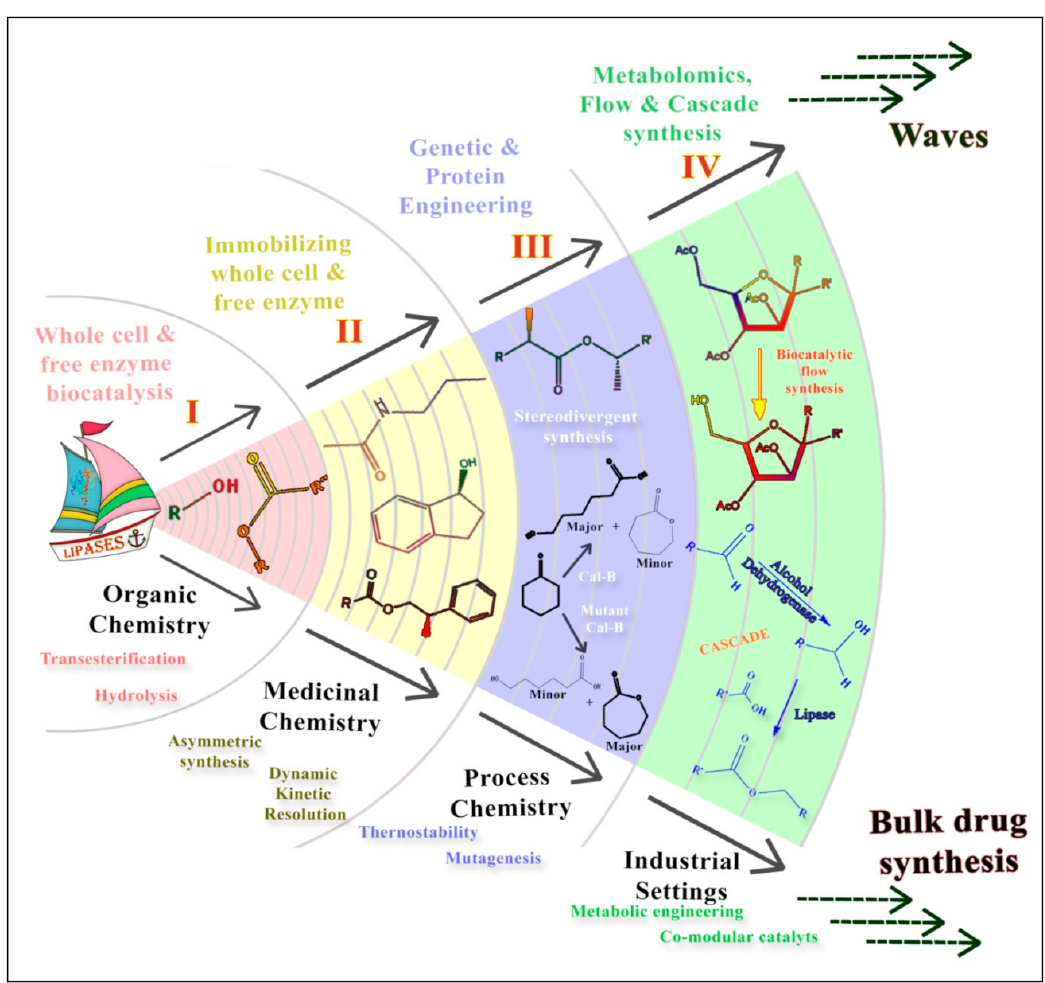
Figure 1. Evolution of Lipases through different waves of biocatalysis